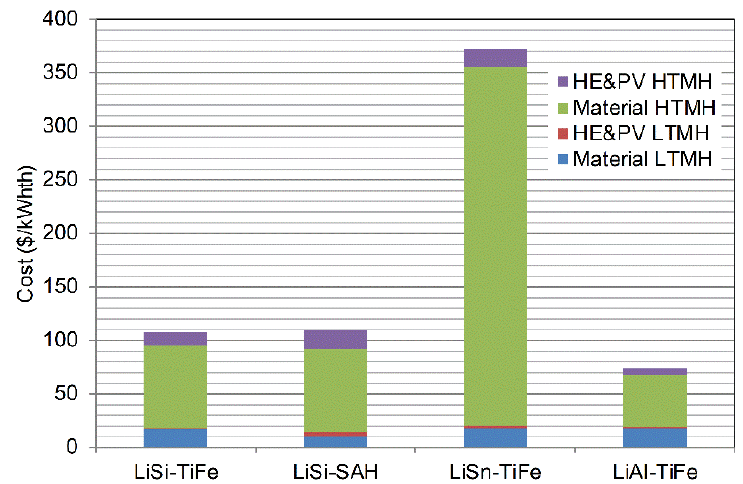
Figure 2. Thermal energy storage system specific installed costs.